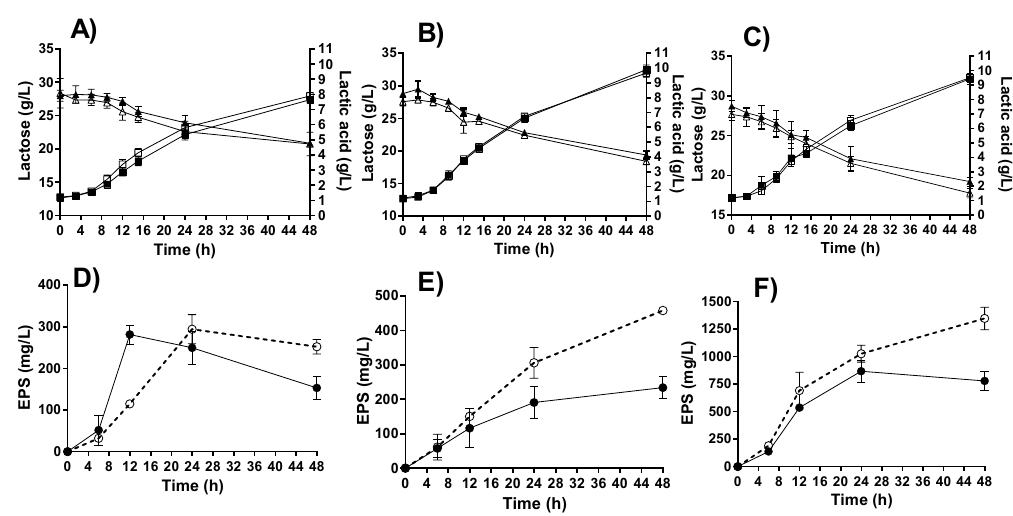
(cid:8) ) production by (cid:35)